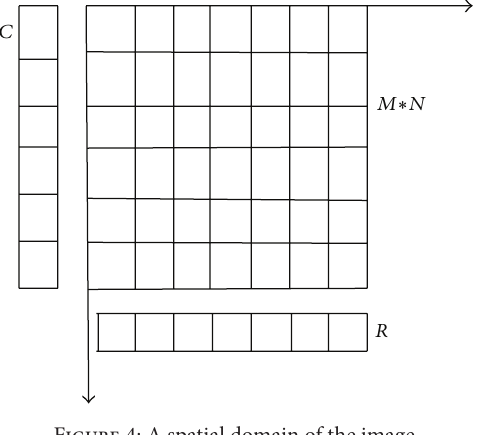
Figure 4: A spatial domain of the image.